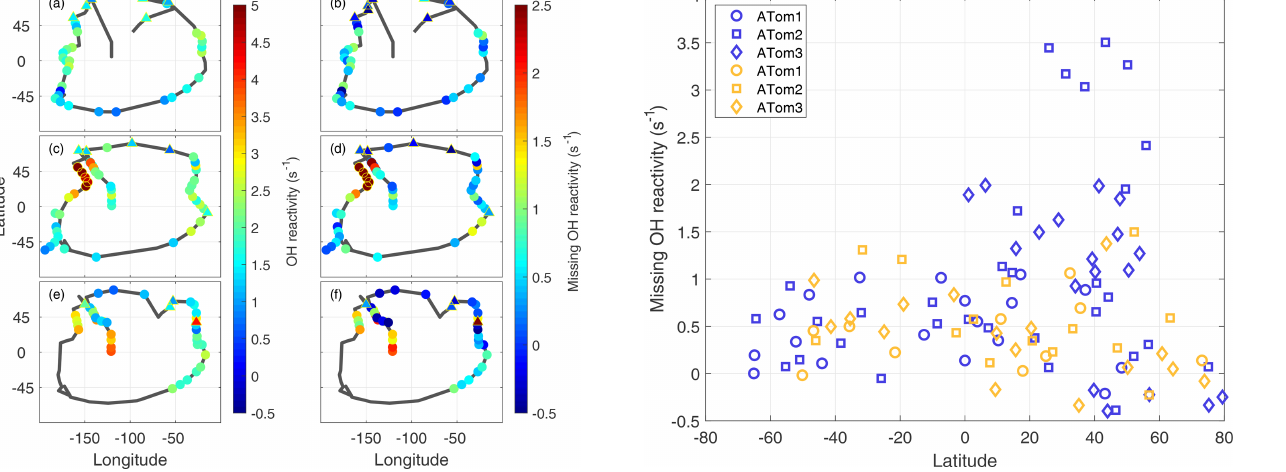
Figure 7. Global measured OH reactivity (a, c, e) and missing OH reactivity (b, d, f) for ATom1 (August), ATom2 (February), and ATom3 (October) at the per-dip time resolution. The black lines trace the flight path during each deployment, identical to the yellow tracks in Fig. 1. Color indicates the measured OH reactivity ( − 0 . 5 to 5s − 1 scale) and the missing OH reactivity ( − 0 . 5 to 2.5s − 1 scale), while the yellow open circles indicate values in ATom2 above 2s − 1 that were not included in the correlation analysis. Triangles outlined by yellow are overland values for both measured OH reactivity and missing OH reactivity.